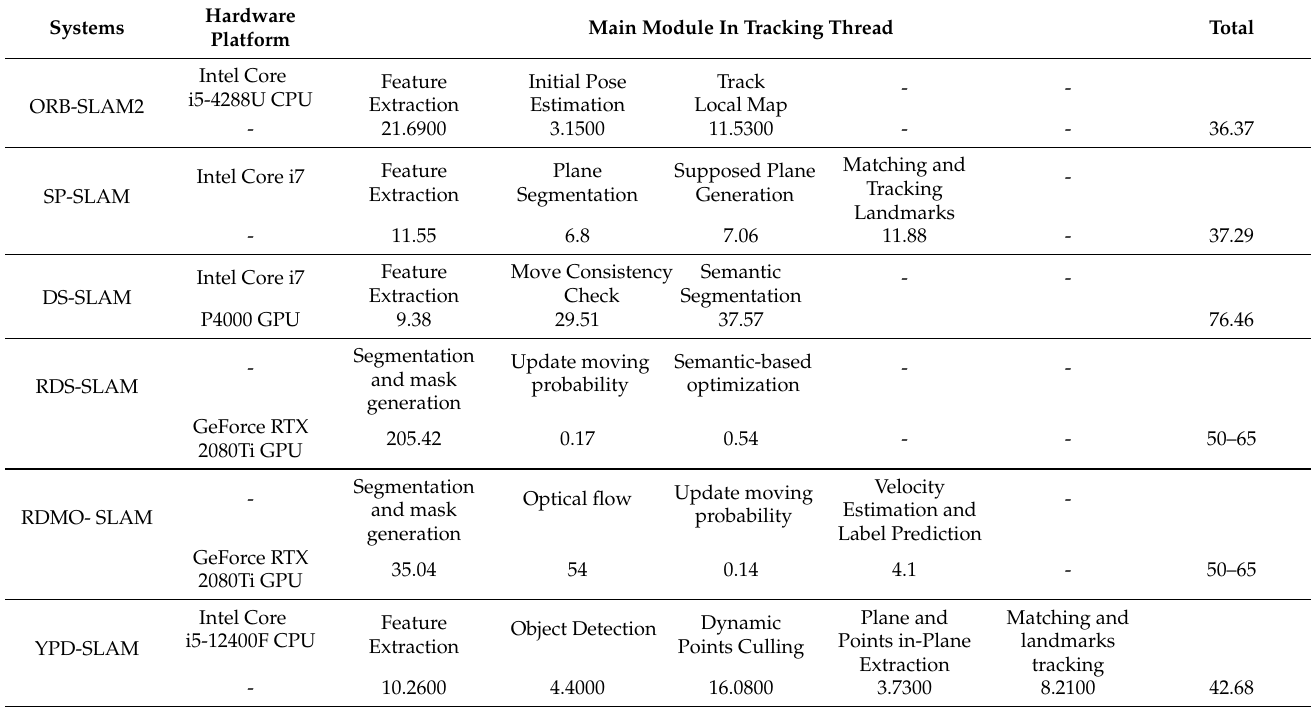
Table 6. The average operation time of principal components in various latest algorithms